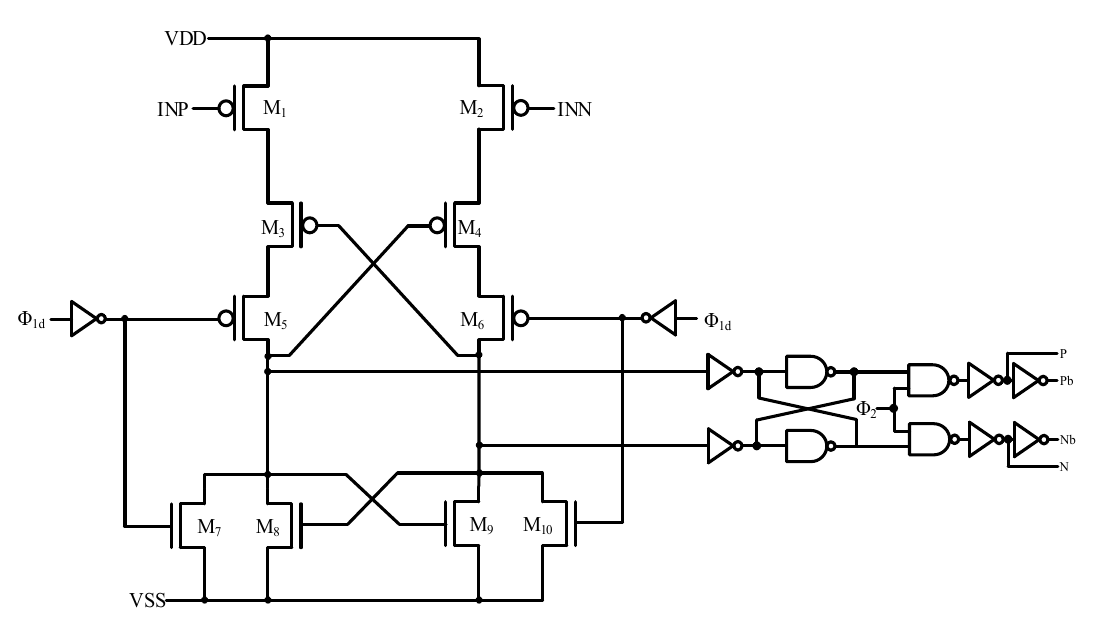
Figure 8. A schematic of the single-bit quantizer.